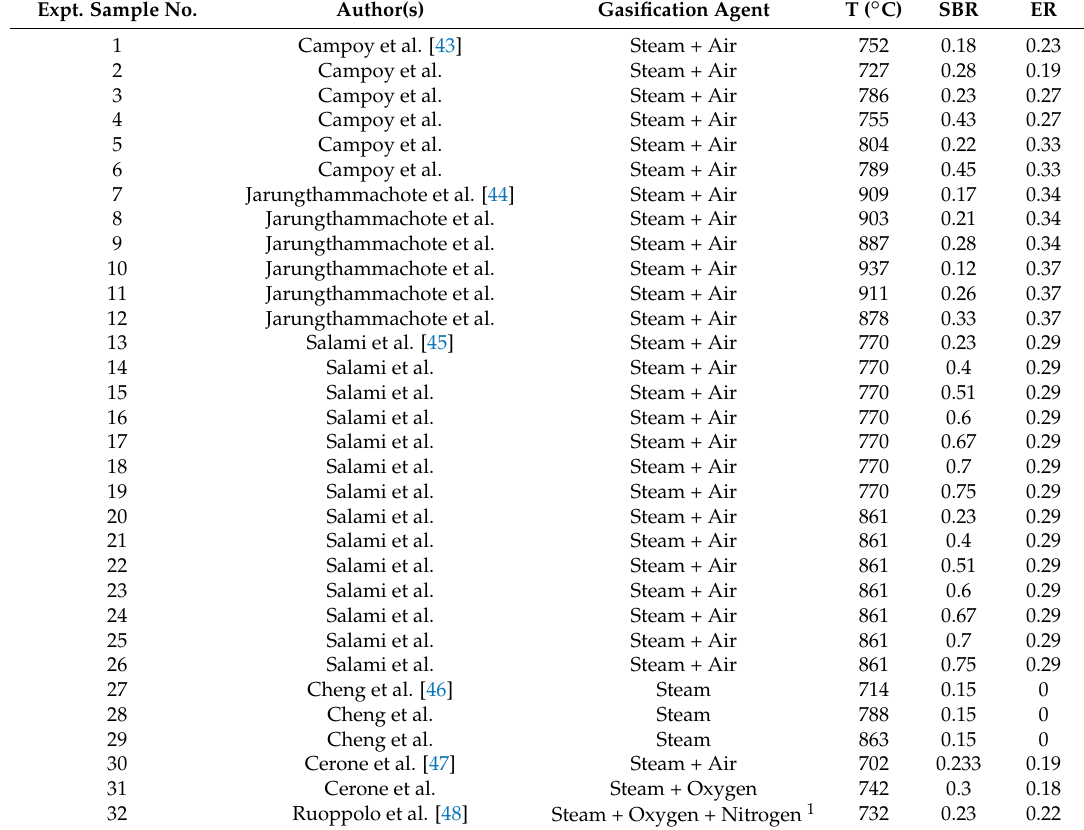
Table 1. Operating conditions for the experimental runs of gasification. Expt. Sample